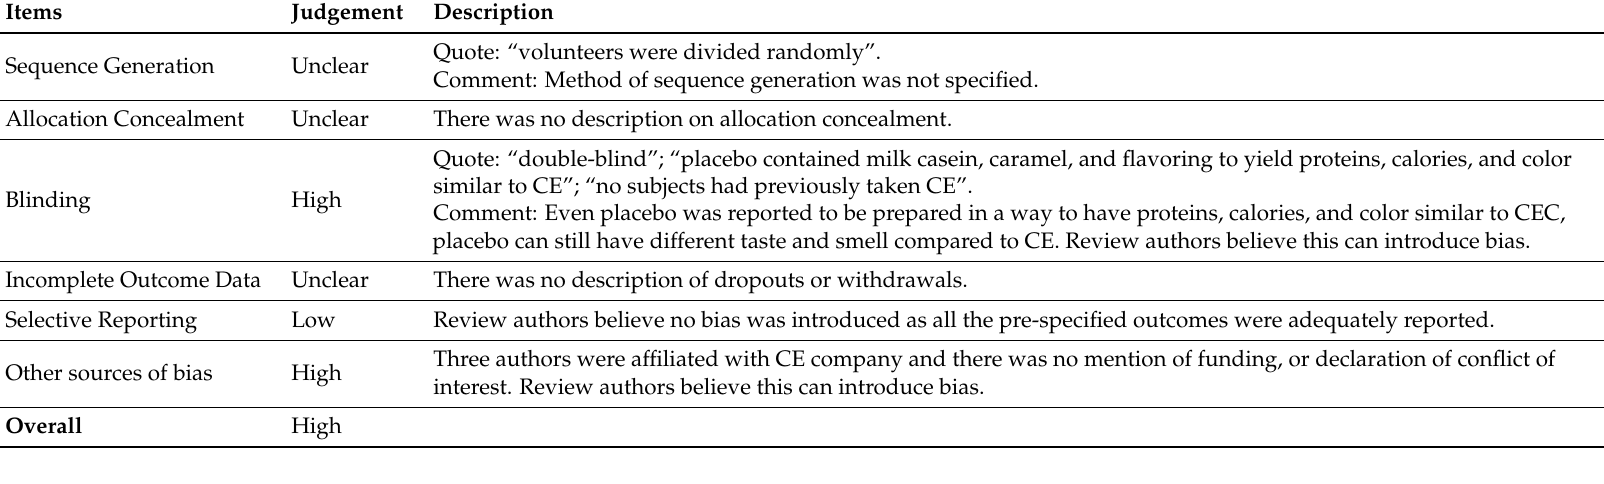
Table A5. Risk of bias assessment of Konagai 2013, [3].